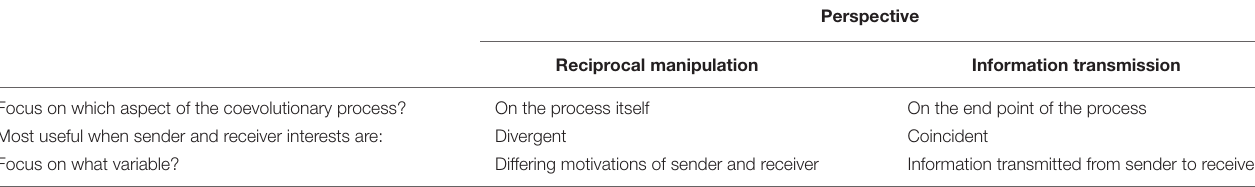
TABLE 3 | Differences between reciprocal manipulation and information transmission